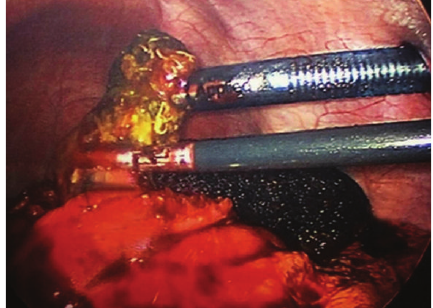
Figure 4: Gastrotomy